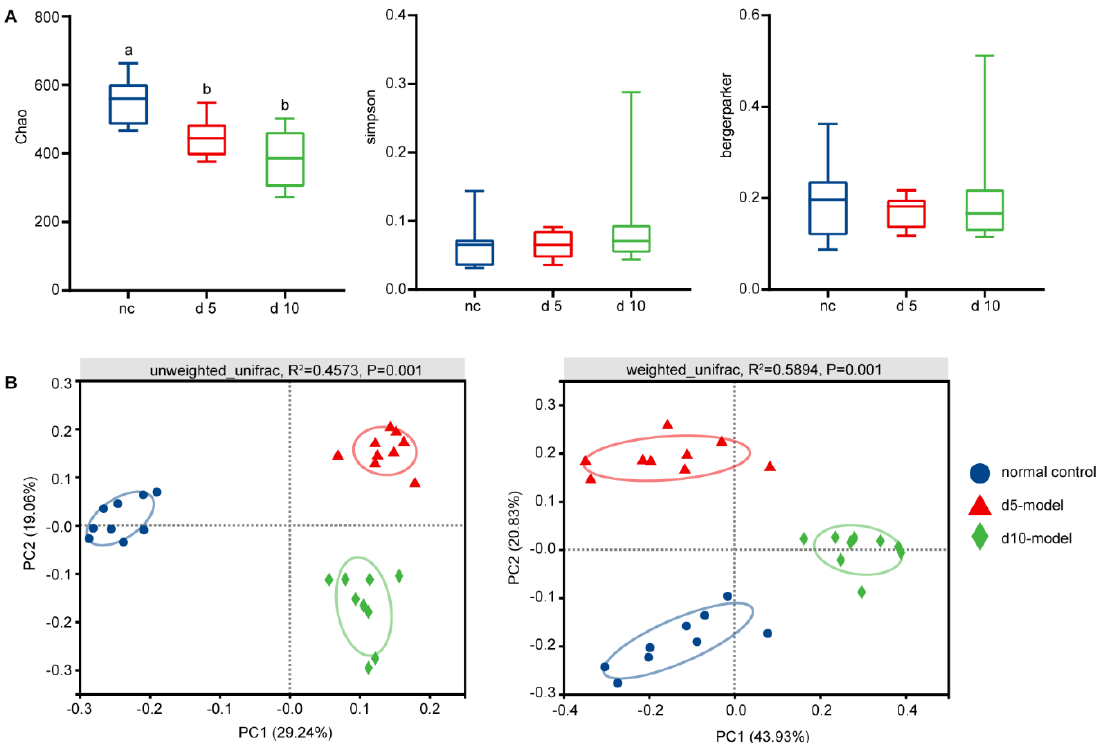
Figure 3. The changes in gut microbiota diversity. ( A ) Alpha diversity changes. ( B ) Principal coordinate analysis by unweighted UniFrac ( left ) and weighted UniFrac method ( right ), n = 9. Data are compared using Kruskal–Wallis tests with Benjamini–Hochberg correction.